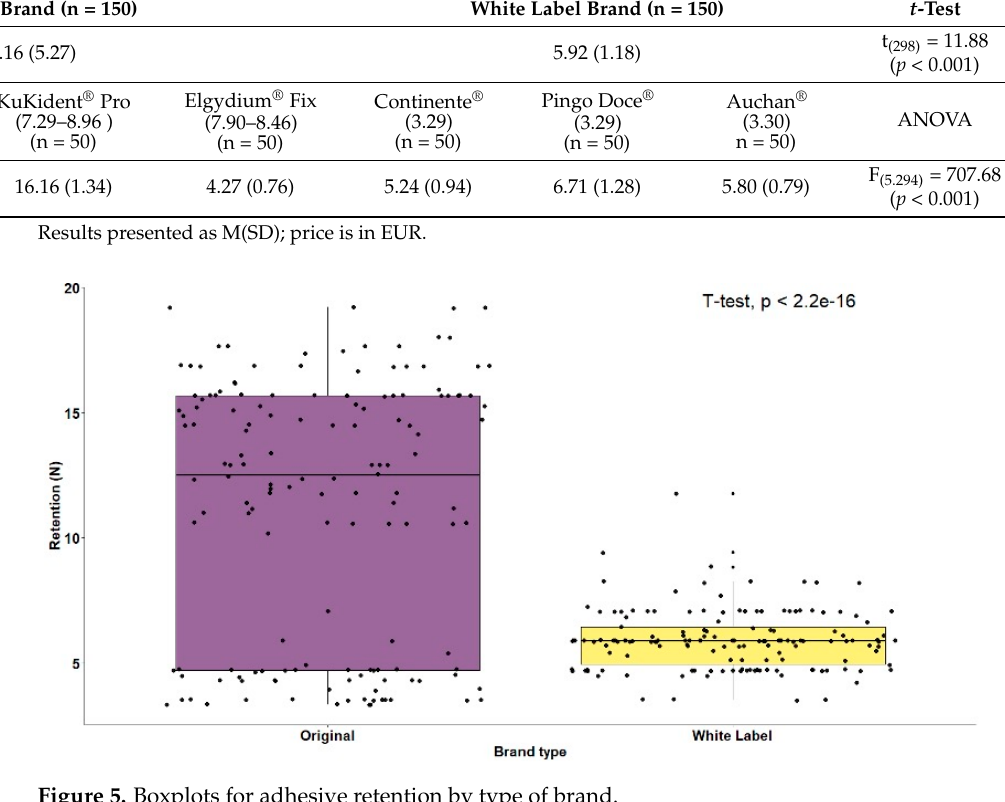
Table 2. Adhesive retention compared by type of brand and brand.